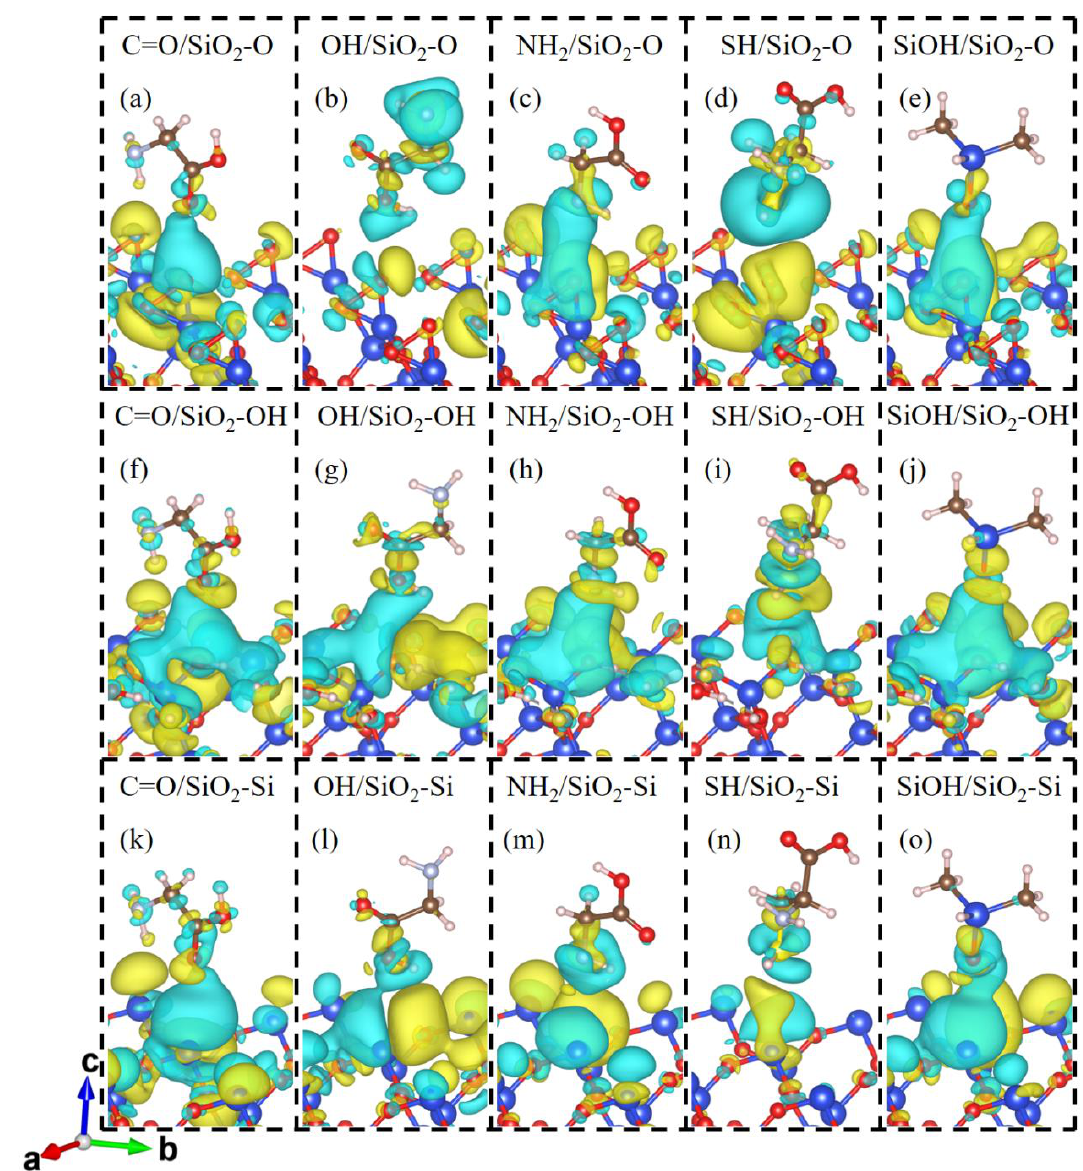
Figure 2. Charge density difference for the contact systems of ( a ) C=O/SiO 2 -O, ( b ) OH/SiO 2 -O, ( c ) NH 2 /SiO 2 -O, ( d ) SH/SiO 2 -O, ( e ) SiOH/SiO 2 -O, ( f ) C=O/SiO 2 -OH, ( g ) OH/SiO 2 -OH, ( h ) NH 2 /SiO 2 -OH, ( i ) SH/SiO 2 -OH, ( j ) SiOH/SiO 2 -OH, ( k ) C=O/SiO 2 -Si, ( l ) OH/SiO 2 -Si, ( m ) NH 2 /SiO 2 -Si, ( n ) SH/SiO 2 -Si, and ( o ) SiOH/SiO 2 -Si. The blue and yellow domains show the electron depleted and accumulated regions, respectively. The value of the iso-surface is set to 2 × 10 −4 e/bhor 3 for the OH/SiO 2 -O and SH/SiO 2 -O systems. The value of the iso-surface is set to 8 × 10 −5 e/bhor 3 for other contact systems.